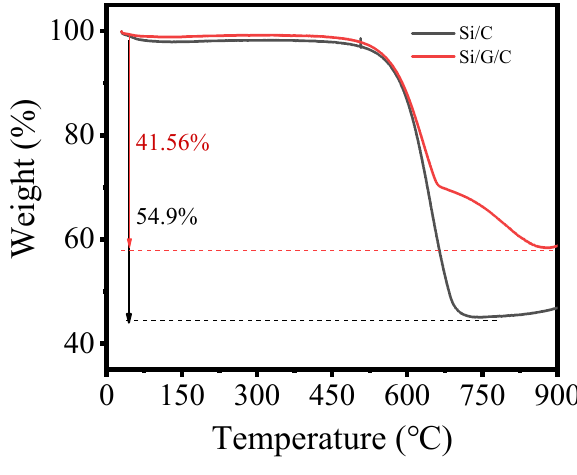
Figure 1. ( a ) XRD patterns; ( b ) Raman spectra of various samples.